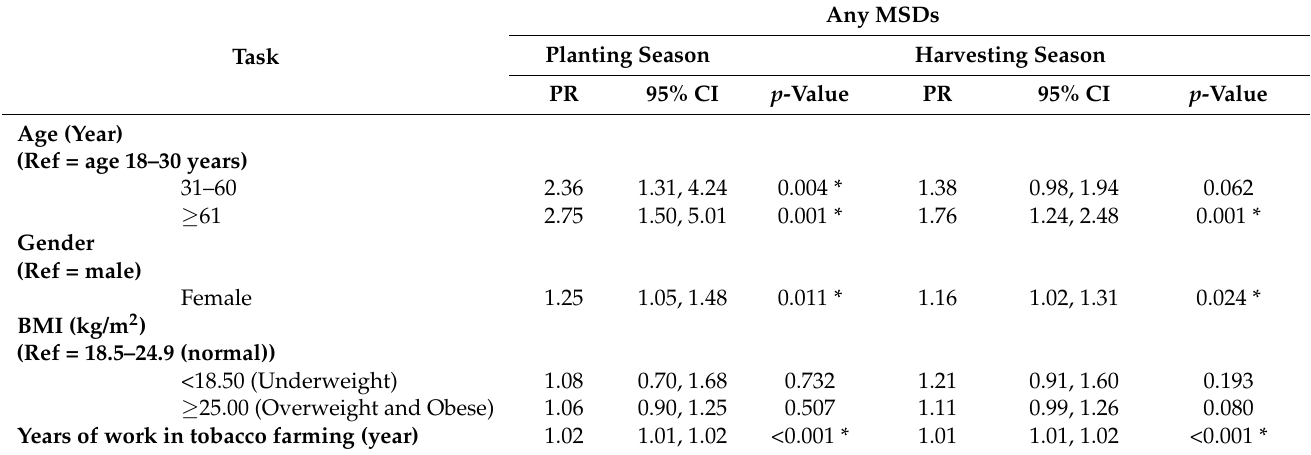
Table 3. Univariate analysis of factors associated with any